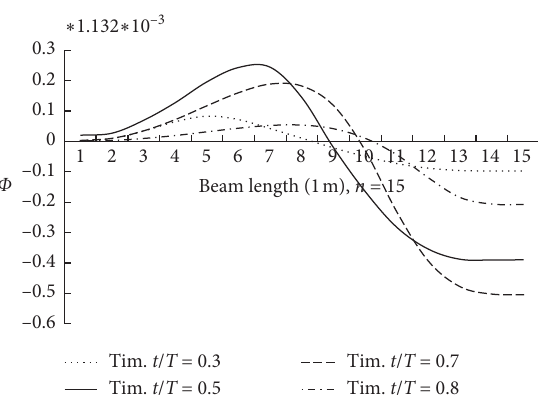
Figure 18: C-S T Beam (3) cross-section